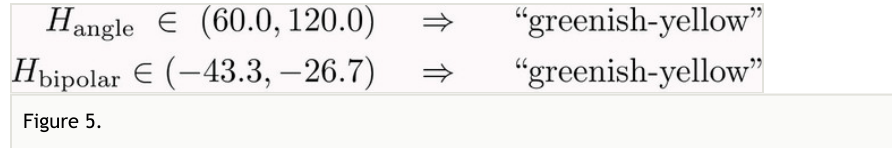
Example of both Hdegree and Hbipolar for proposed hue